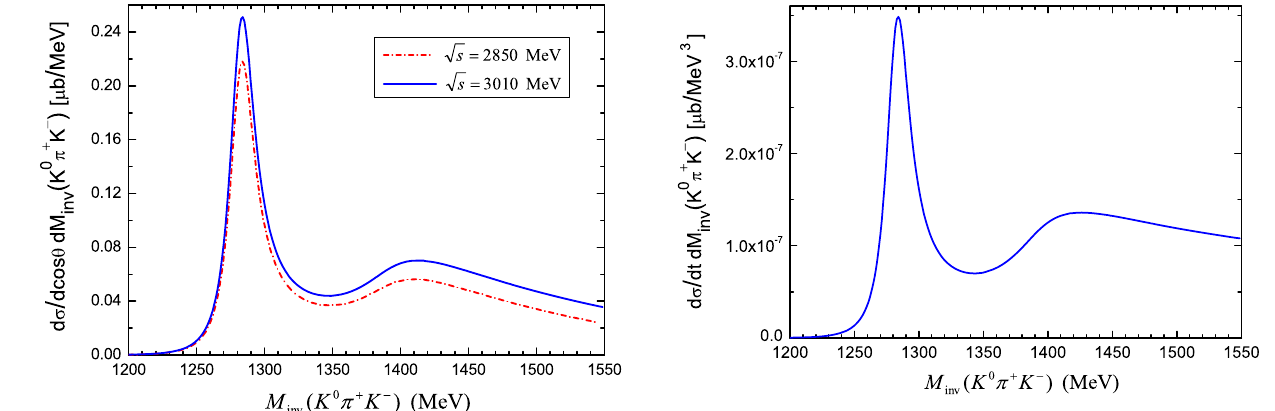
Fig. 4 Differentialcrosssectionforthe K − p → (cid:4) K 0 π + K − reaction √ s = 2850 MeV, 3010 MeV for cos θ = 1 and